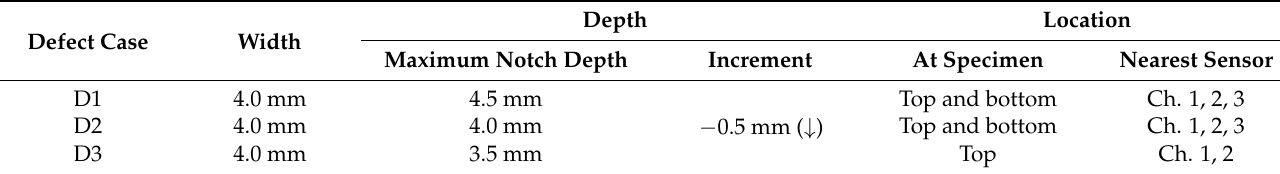
Table 2. Details of the defect